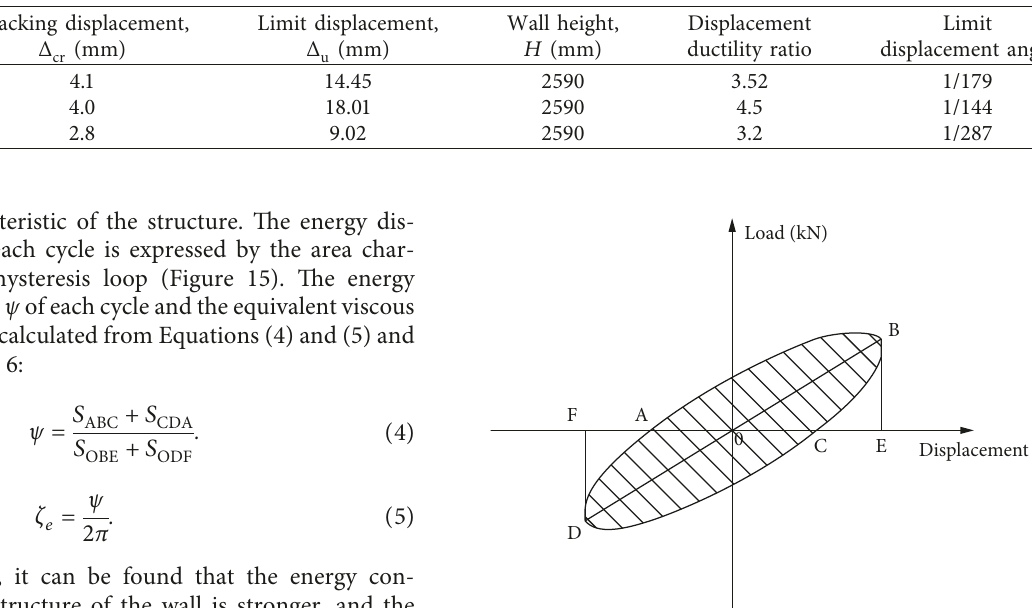
Table 5: Ductility ratio and ultimate displacement angle of specimens.